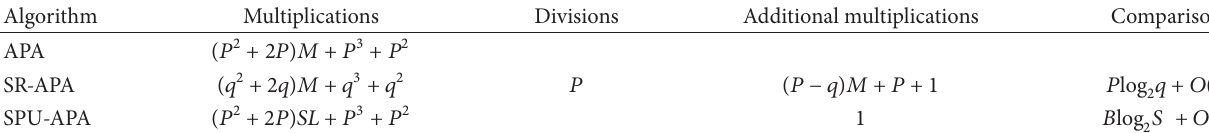
Table 2: Explanation of computational complexity of the APA, SR-APA, and SPU-APA.